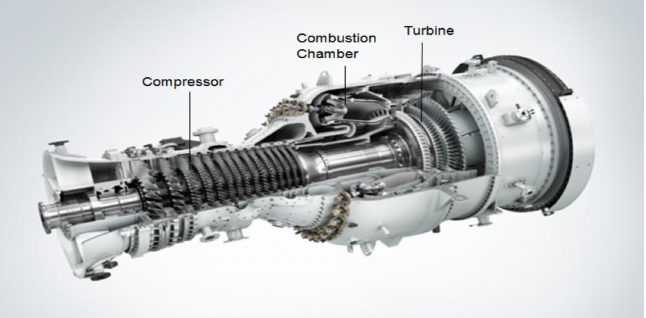
Figure 1. General components in a gas turbine (Siemens Industrial Turbomachinery AB, 2015)